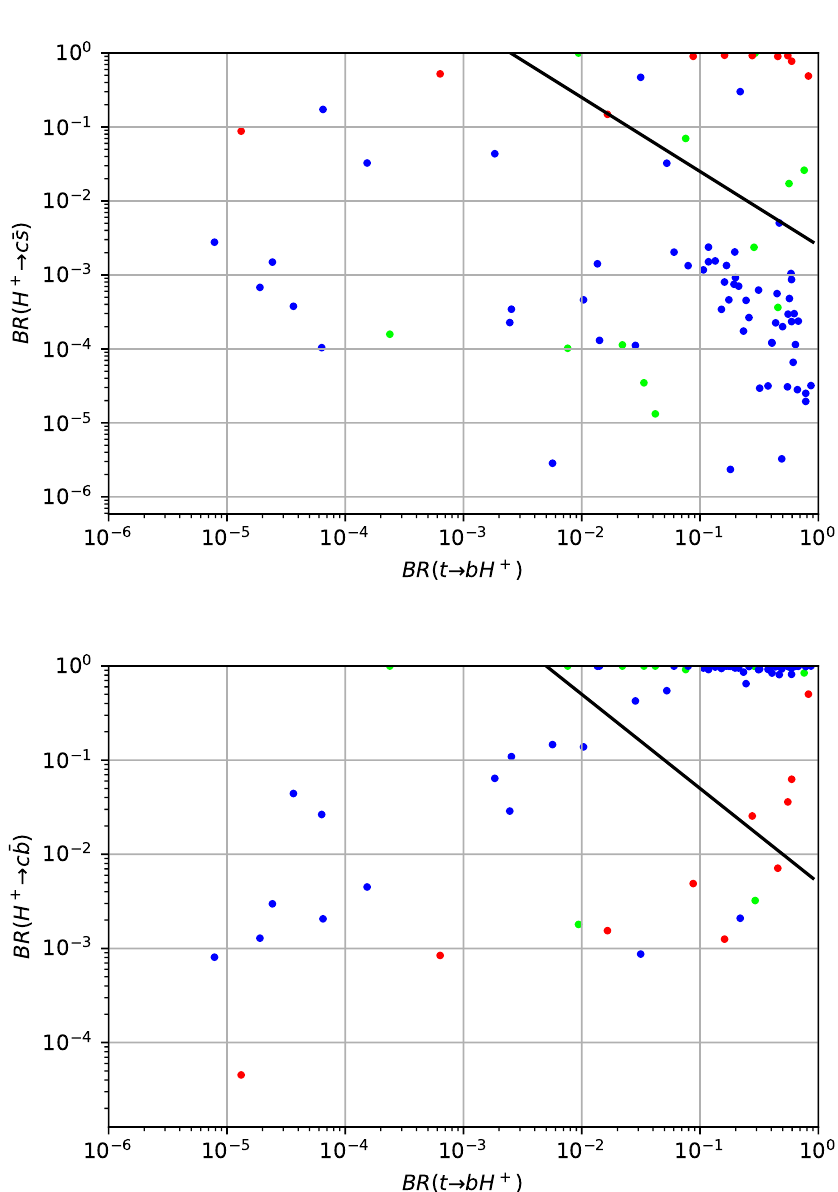
Figure 2. Branching ratios Br ( H + → c ¯ s ) (top) and Br ( H + → c ¯ b ) (bottom) vs. Br ( t → H + b ) . The colors encoding the Yukawa combinations ( B 1 , B 1 ) , ( B 2 , B 2 ) , and ( B 1 , B 3 ) are the same as in Figure 1. The oblique lines corresponds to the LHC upper limits (19) with p = 0.25% for c ¯ s [42] and p = 0.5% for c ¯ b